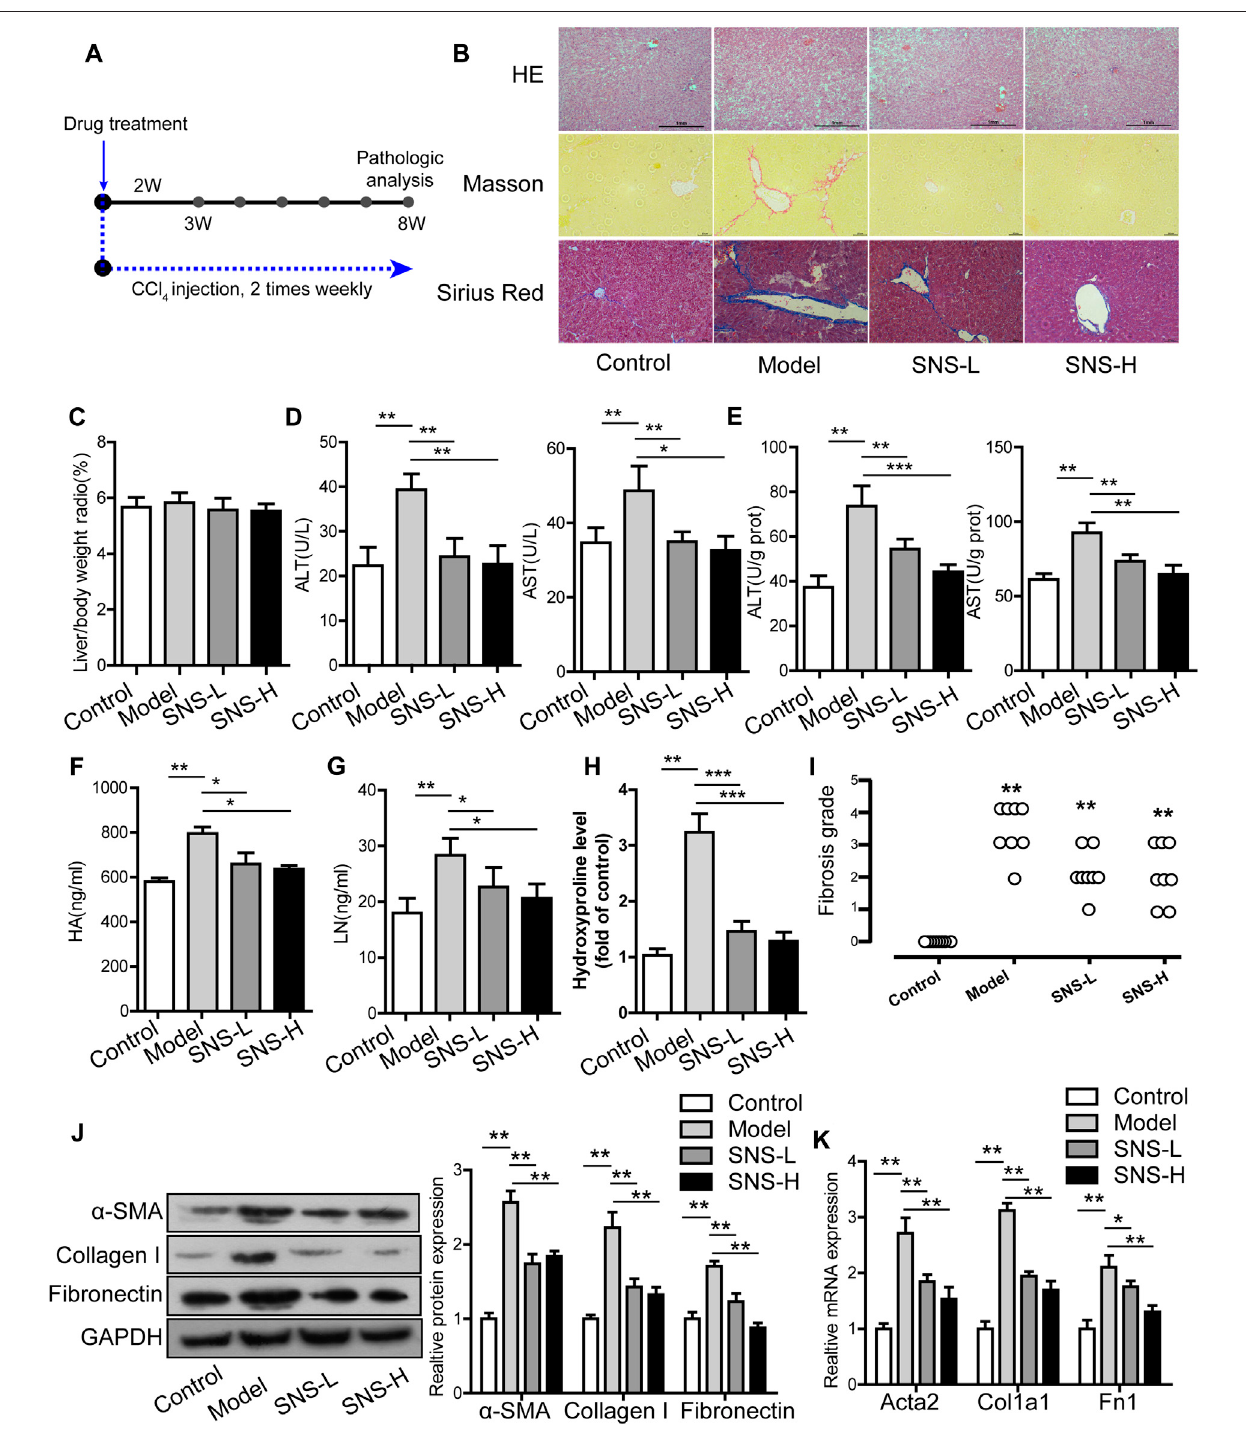
FIGURE 1 | SNS ameliorates hepatic fi brosis in CCl 4 -treated mice. (A) Flowchart of animal experiments. (B) Representative images of liver sections stained with H&E or Masson or Sirius red (magni fi cation, 100 × ). (C) Ratio of liver weight to body weight. (D) Concentrations of ALT and AST in serum. (E) Concentrations of ALT and AST in liver homogenates. (F) Concentrations of HA in serum. (G) Concentrations of LN in serum. (H) Effect of SNS on liver hydroxyproline. (I) Effect of SNS on fi brosis gradingscore. (J) EffectsofSNSonproteinlevelsof α -SMA,collagenIand fi bronectininlivertissue. (K) EffectsofSNSonmRNAlevelsofActa2,Col1a1,andFn1in liver tissue. Data are presented as mean ± SD ( n (cid:2) 6). * p < 0.05, ** p < 0.01, *** p < 0.001 compared to control or model group.